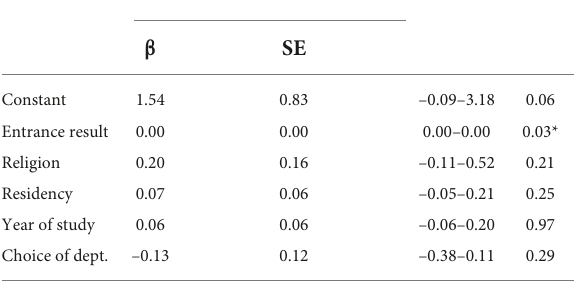
TABLE 4 Multivariable linear regression of sociodemographic variables with cumulative grade point average (cGPA) of anesthesia students at Debre Tabor University (DTU) and University of Gondar (UoG), 2021.